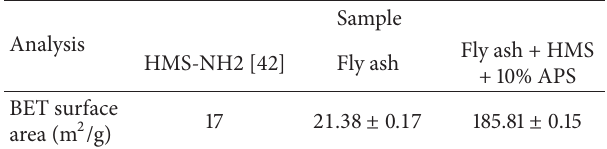
Table 2: Comparison of the BET analysis of functionalized hexago- nal mesoporous silica, biomass ash, and synthesized